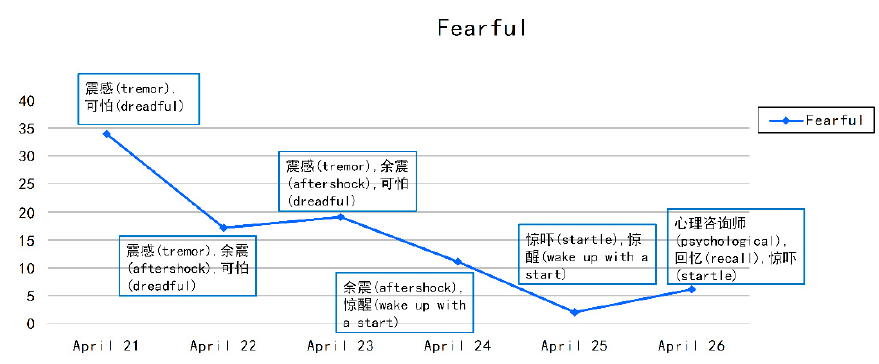
Figure 13. Sequence diagram of fear.